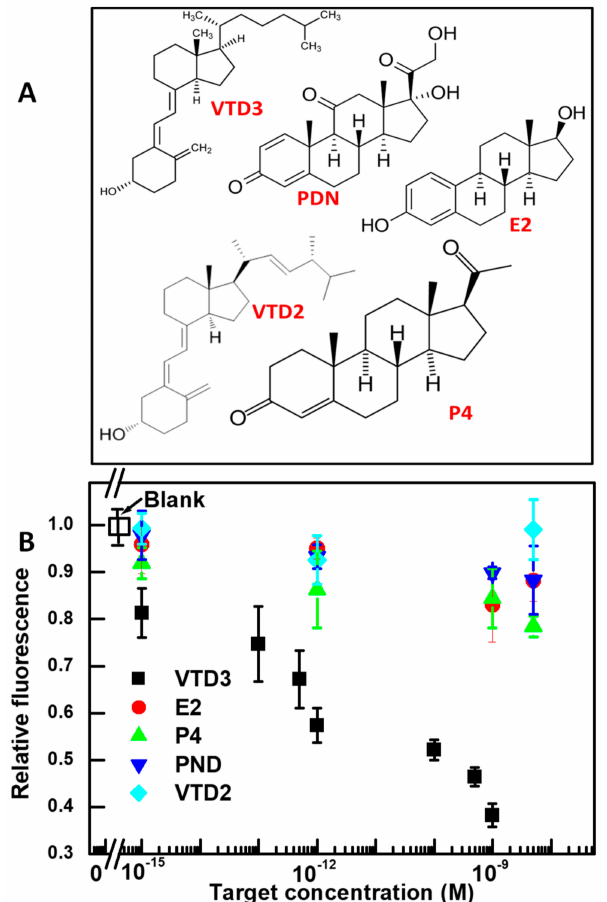
Figure 3. ( A ) Molecular structures of VTD3 and the interfering targets used to evaluate the specificity of the aptasensors developed in the study. ( B ) Di ff erential change in fluorescence (relative fluorescence) vs. concentration of VTD3 and interfering molecules. The concentrations of VTD3 aptamer and curcumin are 100 nM and 0.6 µ M, respectively. Error bars represent standard deviations from two